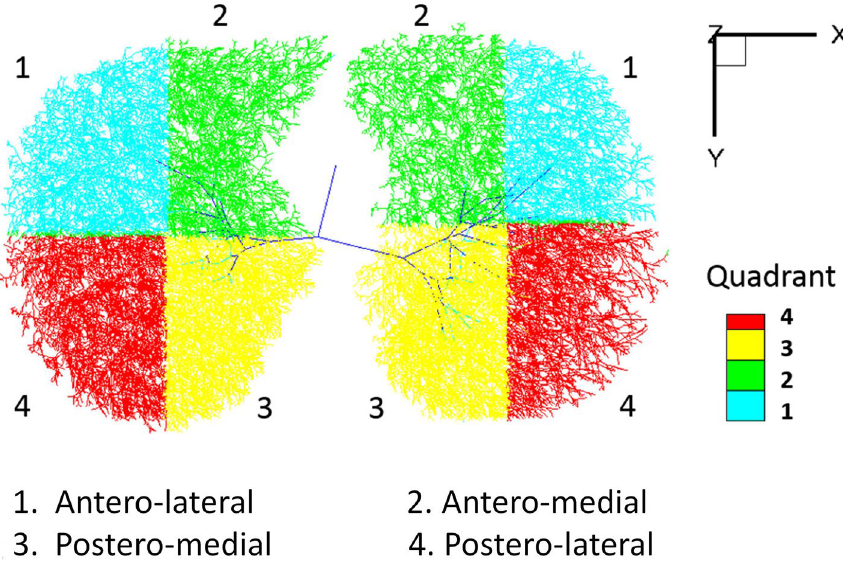
Figure 7. Quadrants of the modeled conducting airways. Quadrants are color-coded by the four divisions of the diaphragms. We defined the center points of the diaphragm on xy-plane by the center points between the maximum and minimum x coordinates and maximum and minimum y coordinates.